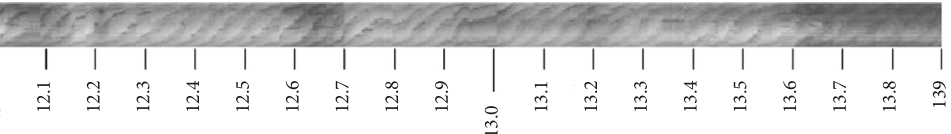
Figure 10: The detected map of roof surrounding rock.